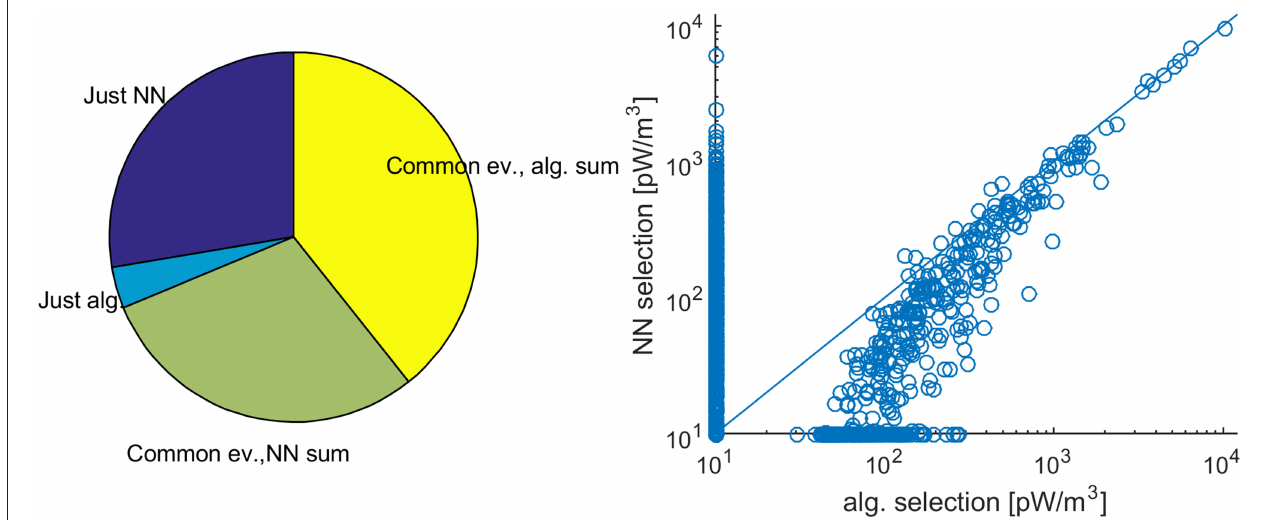
FIGURE 4 | Comparison between the algorithmic approach and NN output. Pie chart representation of the total cumulative sum of E · J (left) and scatter plot of the cumulative sum of E · J for individual events, as derived by the two procedures (right). The unit for the cumulative sum of E · J is pW/m 3 . The scatter plot is presented on logarithmic scale, in order to emphasize the more numerous weak events (compare with Figure 2 ). The points on the x and y axis are identified just by the algorithmic and NN approach, respectively, and the actual cumulative sums are 0. In order to make these points visible in logarithmic representation, the value of 0 was changed artificially to 10. See text for